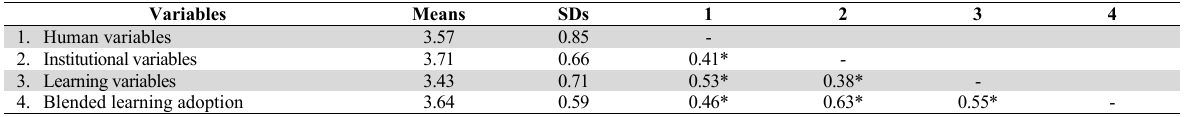
Means, SDs and Pearson correlations Variables